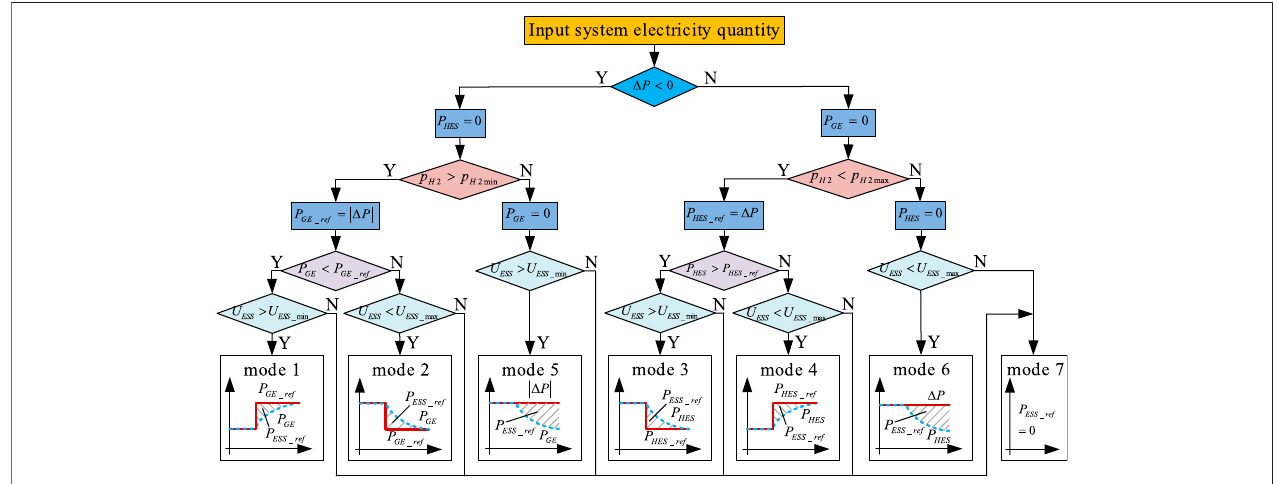
FIGURE 5 | Flowchart of the system power coordination control strategy.